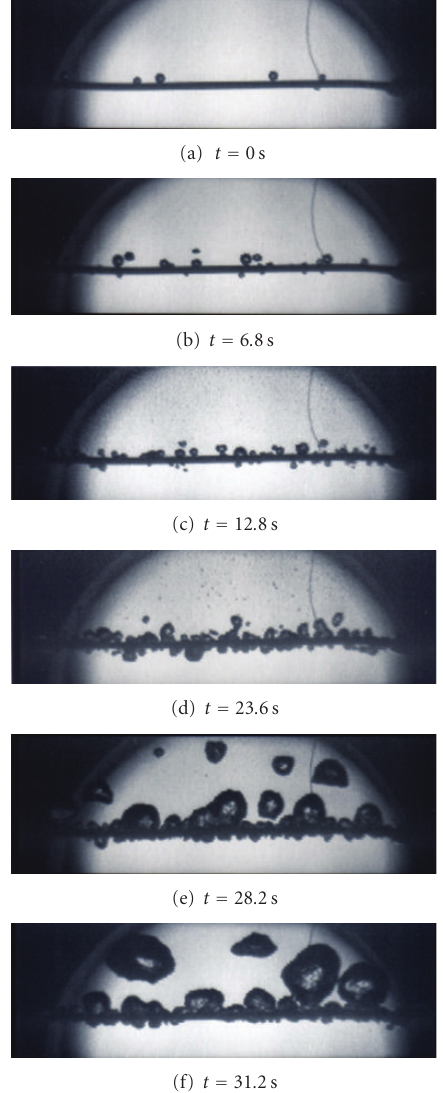
Figure 9: Vapor film behavior during transition to fully developed nucleate boiling (FDNB) for a period of 10 s at atmospheric pres- sure in saturated